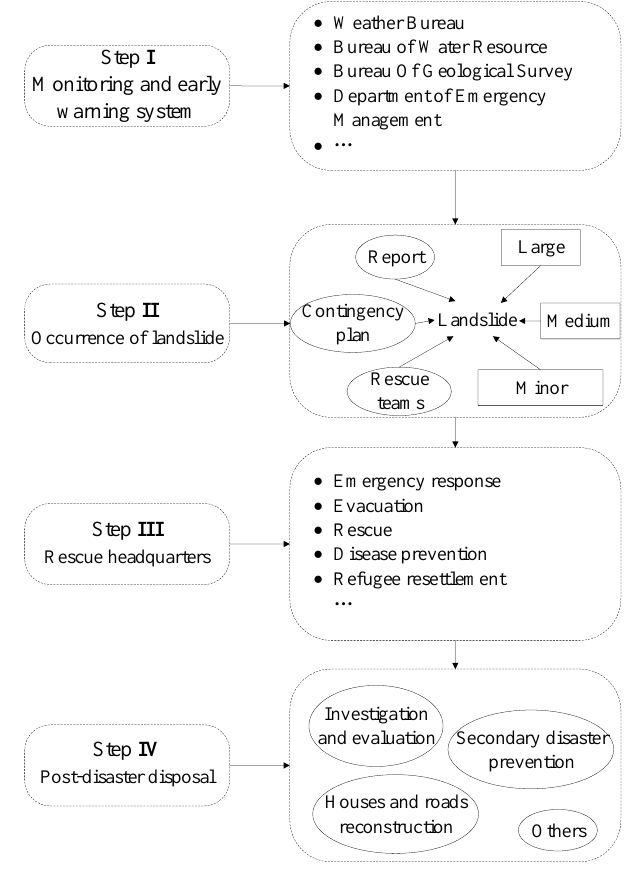
Figure 8. Flow chart of geological disaster emergency treatment in China.